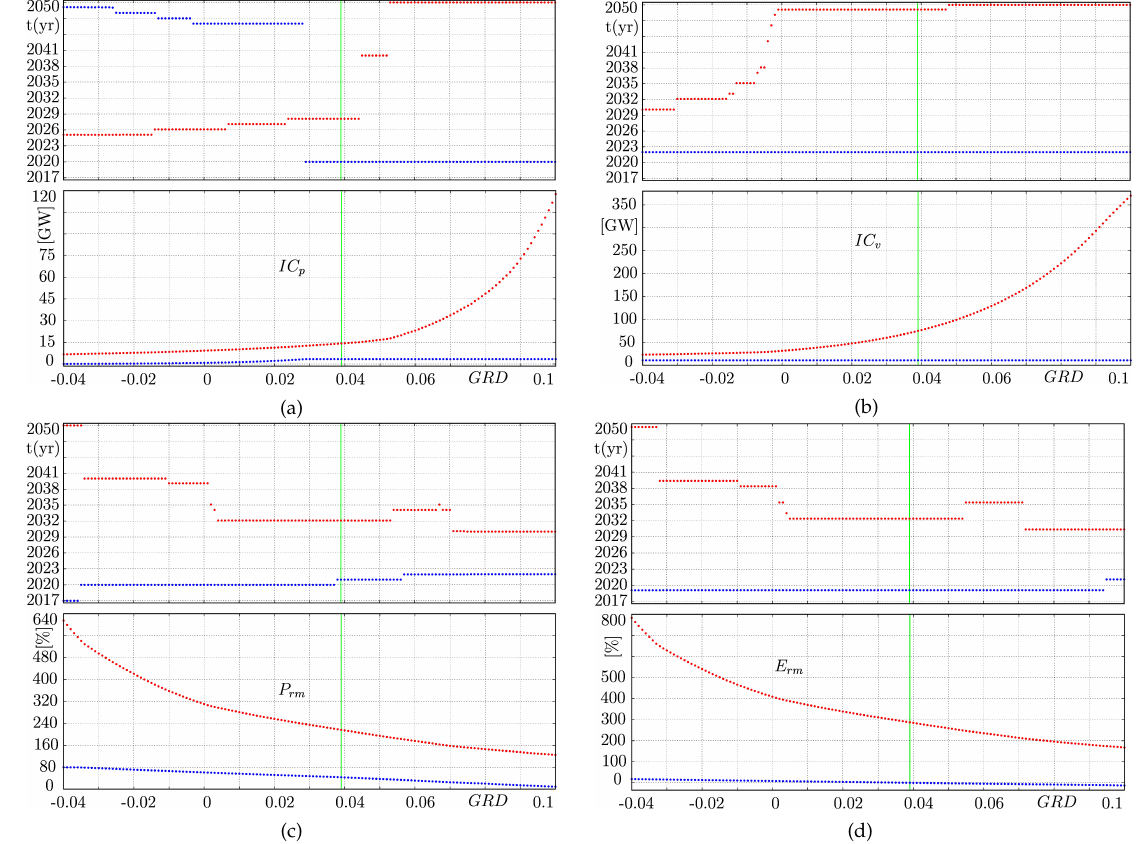
Figure 12. Confidence limits of the GRD scenarios together with their time of occurrence, when seasonality and ENSO phenomenon are considered. The marked green vertical line represents the Colombian case ( GRD = 0.039) ( a ) IC p , ( b ) IC v , ( c ) P rm , and ( d ) E rm